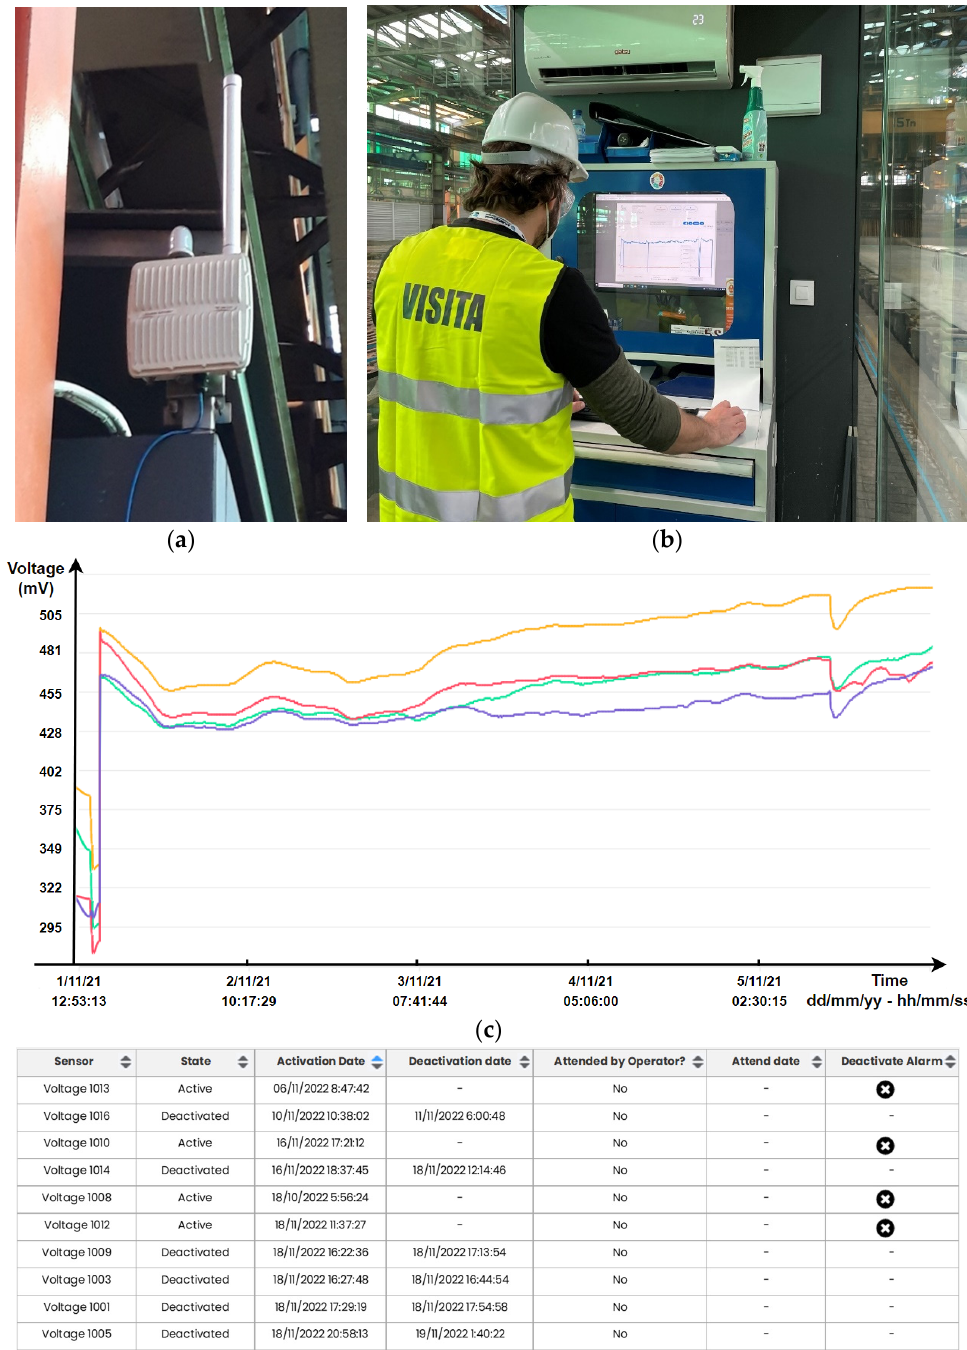
Figure 9. ( a ) Deployed gateway ( b ) and server. ( c ) Graphical interface of four-cell voltage evolution ( d ) and short-circuit alarm management graphical